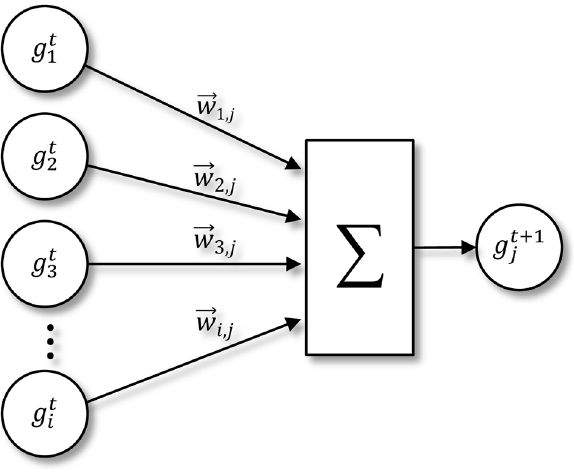
Figure 6. Artificial neural network fitness function. Each contributory gene’s expression in the current time point is magnified by its weight of interaction with the target gene. The sum of these contributions determines the expression level of the target gene at the subsequent time point. t indicates the time point in the microarray dataset, n is the number of genes in the pathway, w ! ji is the weight of the interaction between gene i and gene j , g t is the gene expression i value in the microarray set for gene i at time point t .